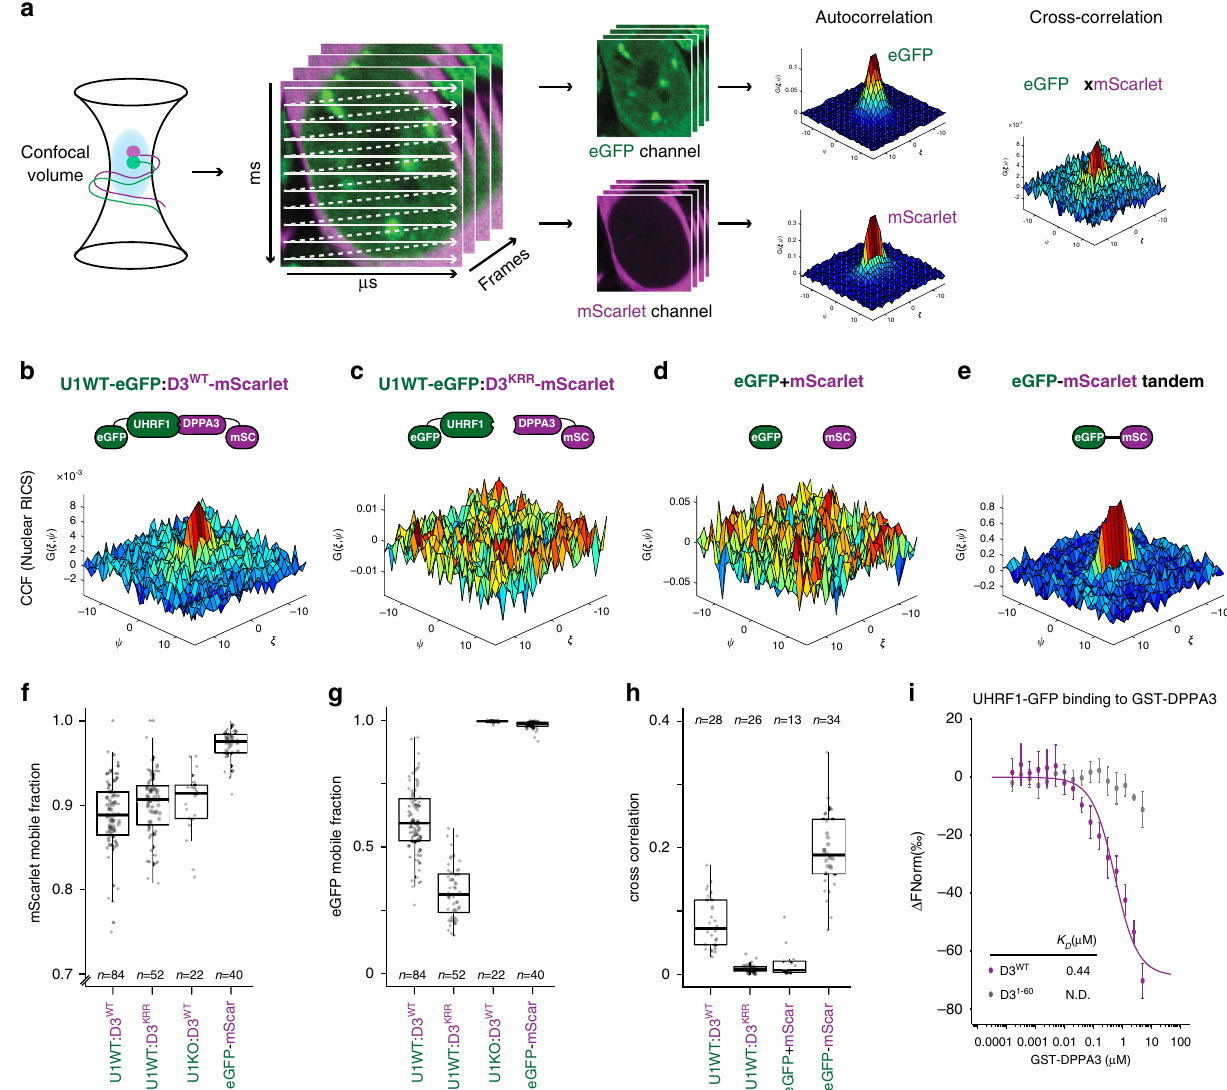
Fig. 6 DPPA3 binds nuclear UHRF1 with high af fi nity prompting its release from chromatin in naïve ESCs. a Overview of RICS and ccRICS. Confocal image series are acquired on a laser scanning confocal microscope, containing spatiotemporal fl uorescence information on the microsecond and millisecond timescales. A spatial autocorrelation function (SACF) is calculated from the fl uorescence image and fi t to a diffusive model. The cross- correlation of intensity between two channels is used to estimate the co-occurrence of two fl uorescent molecules in live cells. The mean cross-correlation of the fl uctuations is calculated and shown in the 3D plot color-coded according to the correlation value. b – e Representative plots of the spatial cross- correlation function (SCCF) between the depicted fl uorescent molecules in cells from each cell line measured: ( b ) wild-type (U1WT:D3 WT ) and ( c ) K85E/ R85E/R87E DPPA3 mutant (U1WT:D3 KRR ), and control ESCs expressing ( d ) free eGFP, free mScarlet (eGFP + mScarlet) and ( e ) an eGFP-mScarlet tandem fusion (eGFP-mScarlet). f , g Mobile fraction of ( f ) mScarlet and ( g ) eGFP species in the cell lines depicted in ( b , c , and e ) and in Uhrf1KO ESCs expressing free eGFP and wild-type DPPA3-mScarlet (U1KO:D3 WT ). The mobile fraction was derived from a two-component model fi t of the autocorrelation function. Data are pooled from three (U1WT:D3 WT , U1WT:D3 KRR ) or two (U1KO:D3 WT , eGFP-mScar) independent experiments. h Mean cross-correlation values of mobile eGFP and mScarlet measured in the cell lines depicted in ( b – e ). The spatial lag in the x-dimension (sensitive to fast fl uctuations) is indicated by ξ , and the spatial lag in the y-dimension (sensitive to slower fl uctuations) is indicated by ψ . Data are pooled from two independent experiments. i Microscale thermophoresis measurements of UHRF1-eGFP binding to GST-DPPA3 WT (D3 WT ) or GST-DPPA3 1 – 60 (D3 1 – 60 ). Error bars indicate the mean ± SEM of n = 2 technical replicates from n = 4 independent experiments. In ( f – h ), each data point represents the measured and fi t values from a single cell where n = number of cells measured (indicated in the plots). In the boxplots, darker horizontal lines within boxes represent median values. The limits of the boxes indicate the upper and lower quartiles; the whiskers extend to the most extreme value within 1.5 x the interquartile range from each hinge. Source data are provided as a Source Data fi